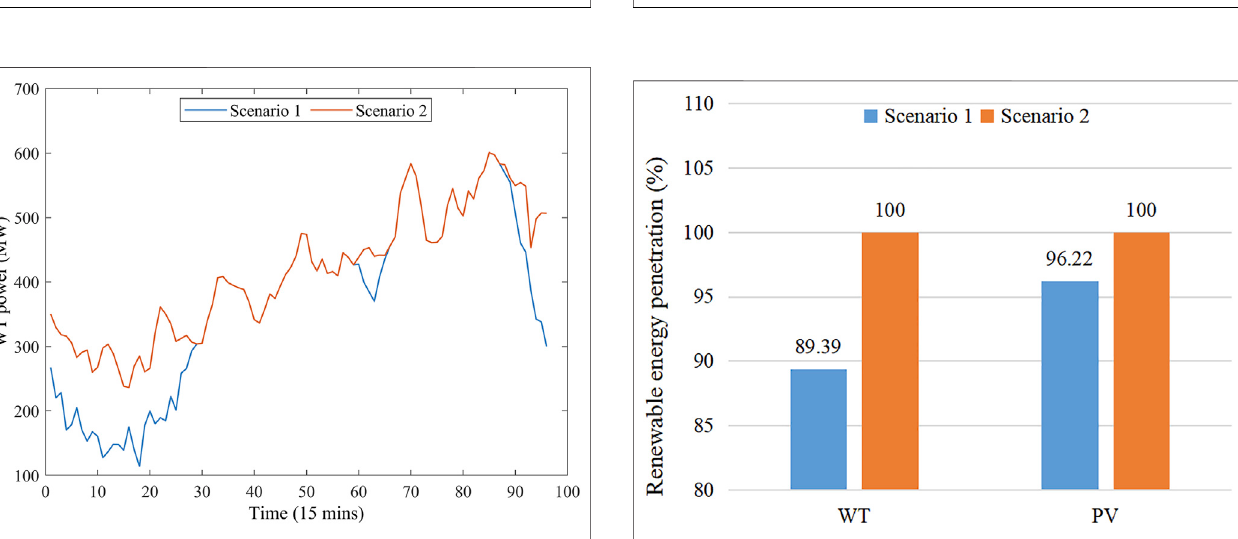
FIGURE 10 | PV power generations in Scenarios 1 and 2.